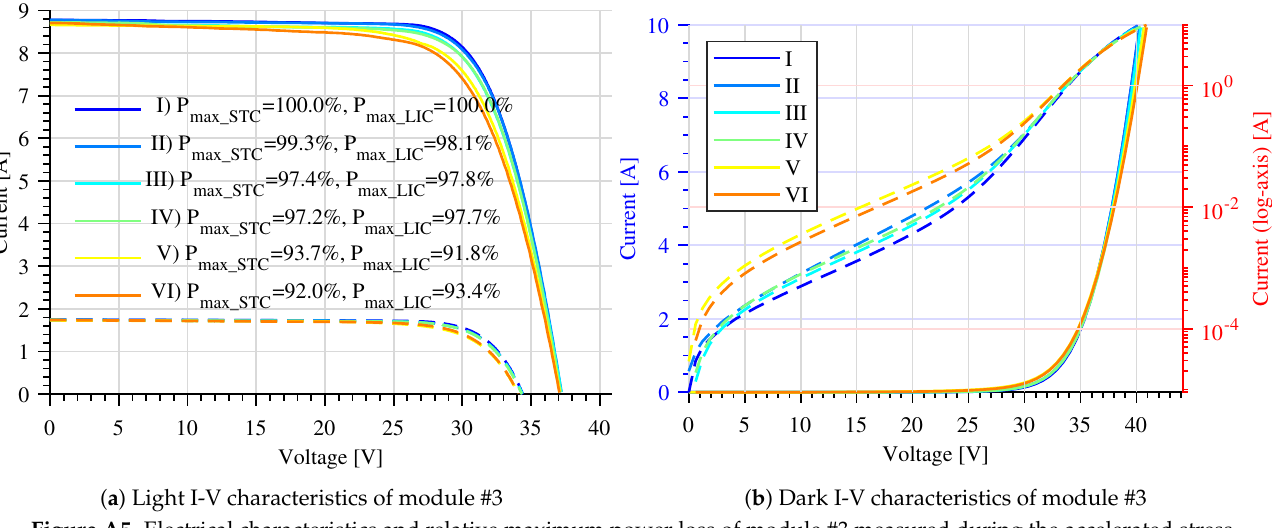
Figure A5. Electrical characteristics and relative maximum power loss of module #3 measured during the accelerated stress test: ( a ) light I-V characteristics measured at STC and low irradiance conditions (LIC, 200 W/m 2 ); ( b ) dark I-V characteristics of module #3 measured at 25 °C.